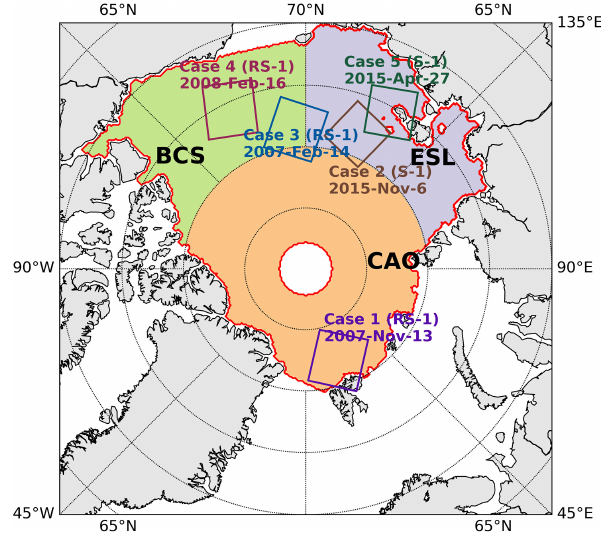
Figure 2. Geographic locations of the SAR images for five cases and outline of the Arctic Basin (red contour, provided by Belmonte Rivas et al., 2018). The Arctic Basin is divided into three subre- gions: the central Arctic Ocean (CAO), the East Siberian and Laptev seas (ESL), and the Beaufort and Chukchi seas